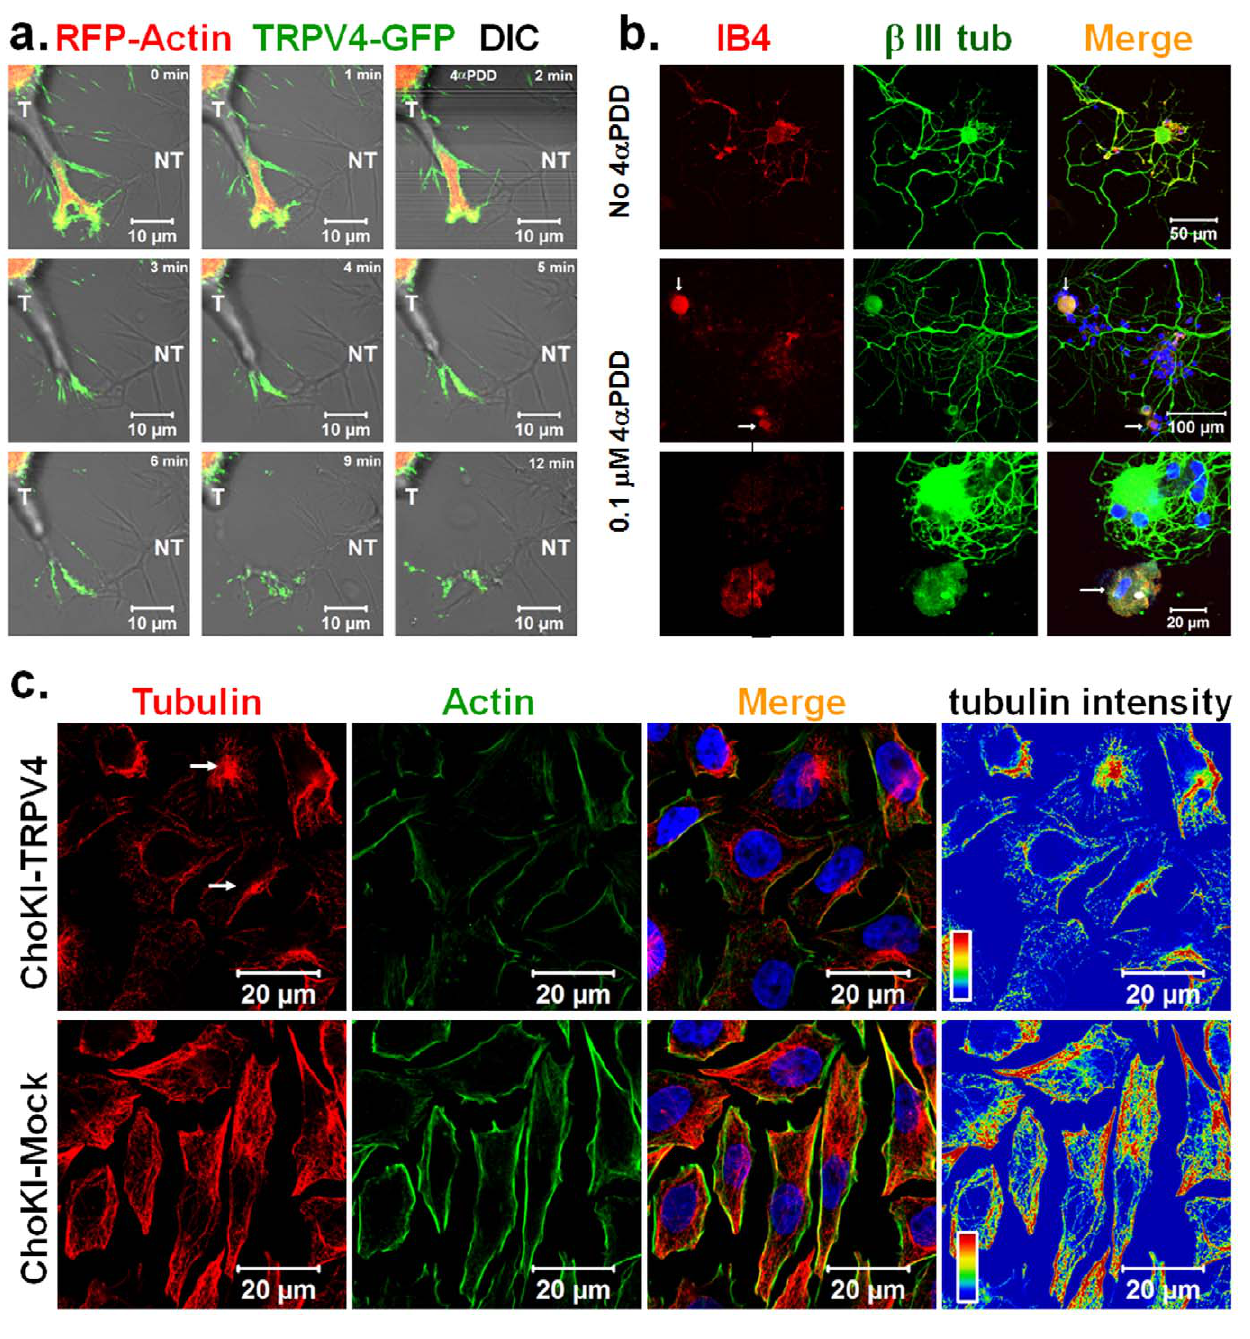
Figure 4. TRPV4 localizes in the growth cone and regulates axonal motility as activation of TRPV4 results in microtubule disassembly. a . Shown are the confocal time series images of live F11 cell expressing TRPV4-GFP (green) and RFP-Actin (red). Fluorescence images were superimposed on the DIC images. Addition of 4 a PDD (1 m M) results in growth cone retraction of the transfected cell (T) but not from the non- transfected (NT) cells. b. Prolonged activation of endogenous TRPV4 reduces neurite outgrowth. Shown are the images of cultured DRG neurons stained for IB4 (red) and b III tubulin (green). IB4-positive neurons extend their neurites in control condition (upper panel). Majority of the IB4-positive neurons do not produce any neurite when 4 a PDD at low dose (0.1 m M) was applied for 36 hours (middle panel). An enlarged view of an IB4-positive and an IB4-negative neuron is shown in the lower panel. Note that the majority of the IB4-negative neurons remain unaffected even in the presence of 4 a PDD. c. CHO-KI-TRPV4 cells that express low level of TRPV4 or CHO-KI-Mock cells that do not express TRPV4 were activated with 4 a PDD (1 m M). After activation, cells were extracted by detergent in isotonic buffer and fixed subsequently by PFA. Cells were immunostained for actin (green) and tubulin (red). CHO-KI-TRPV4 cells loose all the peripheral microtubules but retain filamentous actin after activation and extraction. The stable MTOC regions are marked with arrows. In contrast, CHO-KI-Mock cells remain unaffected. Intensity of the microtubule is shown (red and blue indicate highest and lowest intensity respectively).